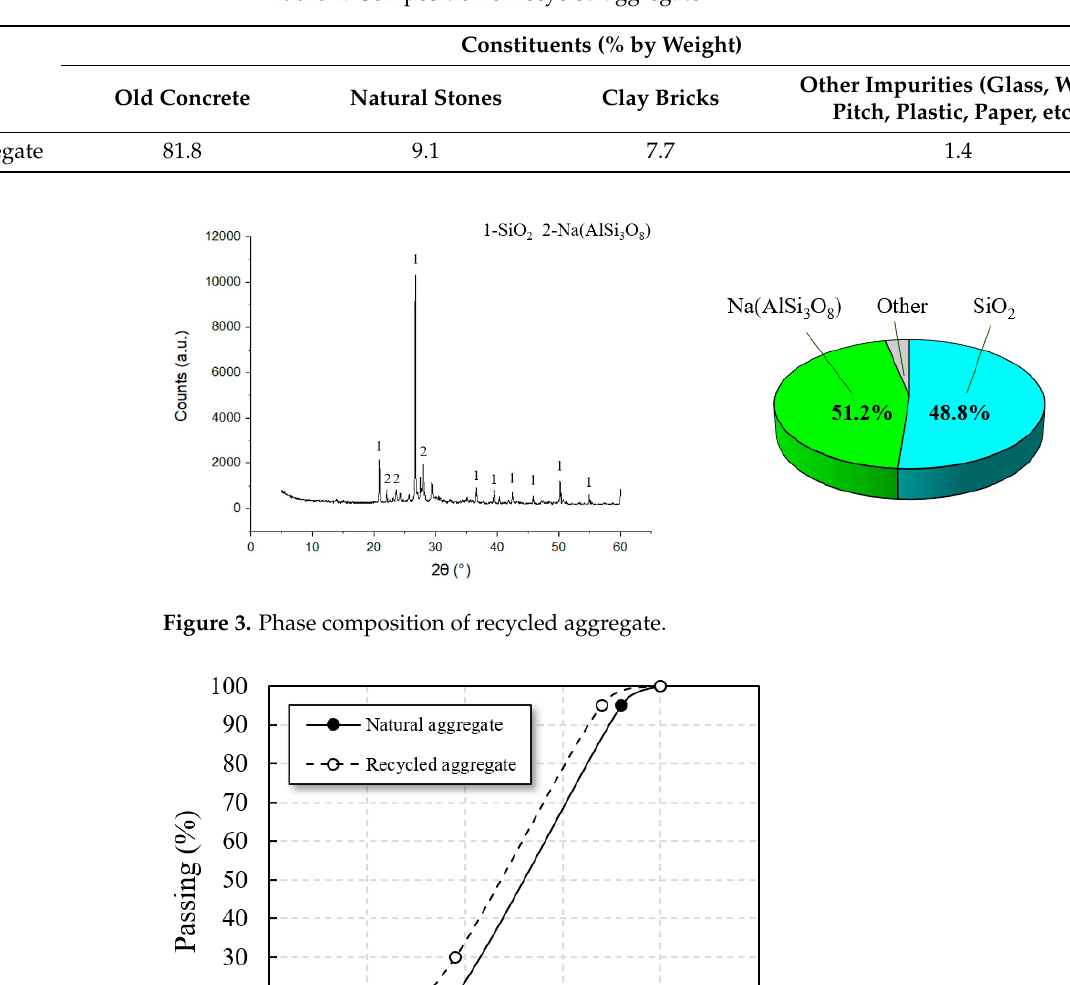
Figure 2. Appearance of natural aggregate and recycled aggregate. Table 4. Composition of recycled aggregate.